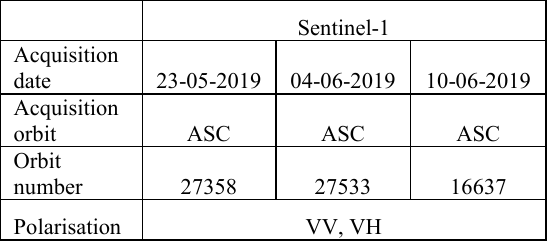
Table 1. Characteristics of the S1 data; vertical-vertical (VV) and vertical-horizontal (VH) polarizations.